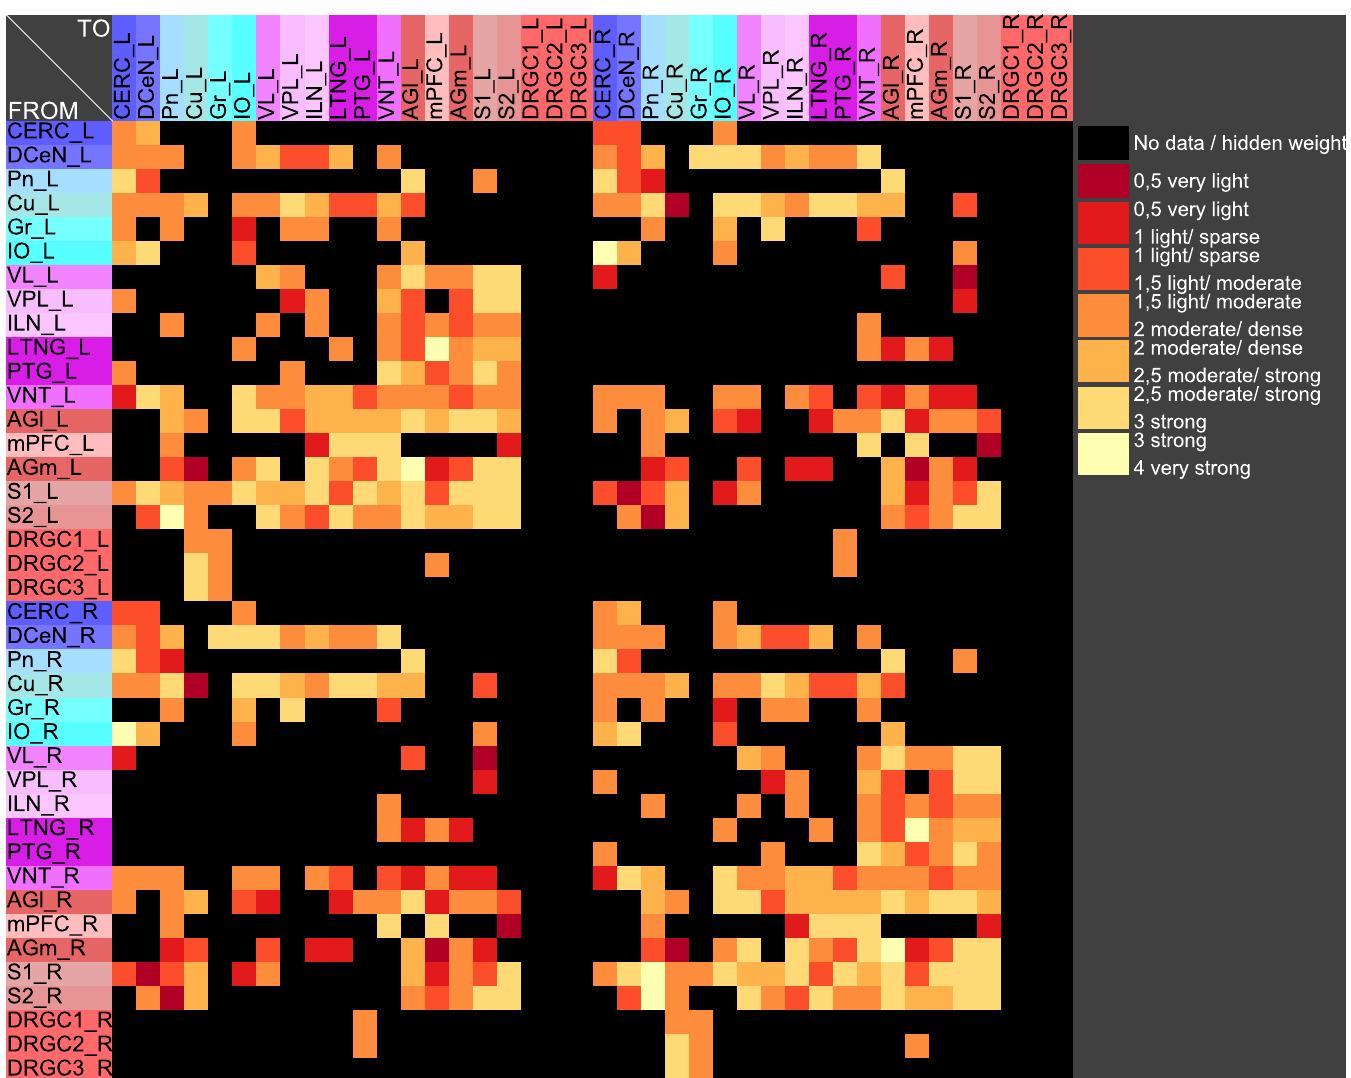
Fig 1. The weighted adjacency matrix of a bilateral mechanosensory subconnectome. The weighted adjacency matrix of the spinal cord, brainstem, diencephalic and cortical connectivity of the mechanosensory pathways. The last character of the area abbreviation indicates the side of the hemisphere: L: left hemisphere, R: right hemisphere. AGl: Lateral agranular prefrontal cortex, AGm: Medial agranular prefrontal cortex, CERC: Cerebellar cortex, Cu: Cuneate nucleus, DCeN: Cerebellar nuclei, DRGC1: Dorsal root ganglion of cervical segment 1, DRGC2: Dorsal root ganglion of cervical segment 2, DRGC3: Dorsal root ganglion of cervical segment 3, Gr: Gracile nucleus principal part, ILN: Intralaminar nuclei, IO: Inferior olive, LTNG: Lateral thalamic nuclear group, mPFC: Medial prefrontal cortex, Pn: Pontine nuclei, PTG: Posterior group, S1: Primary somatosensory cortex, S2: Secondary somatosensory cortex, VL: Ventrolateral thalamic nucleus, VNT: Ventral thalamus, VPL: Ventral posterolateral thalamic